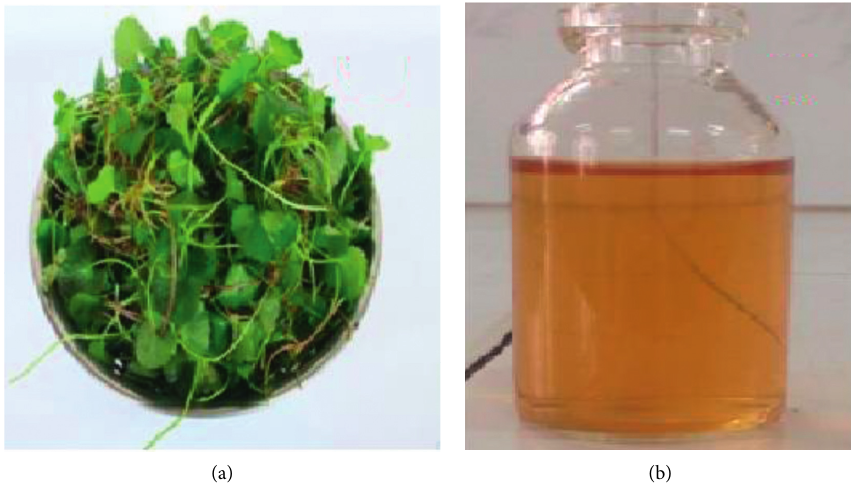
Figure 1: Digital photographs of (a) Centella asiatica (L.) Urban and (b) Centella asiatica (L.) Urban